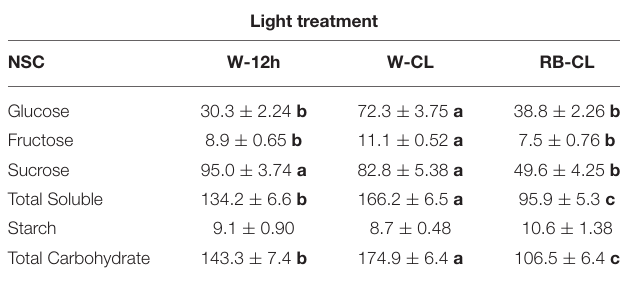
TABLE 1 | Growth parameters and composition of the aerial part of Eruca vesicaria (L.) Cav. plants grown under three different light treatment conditions. Light treatment